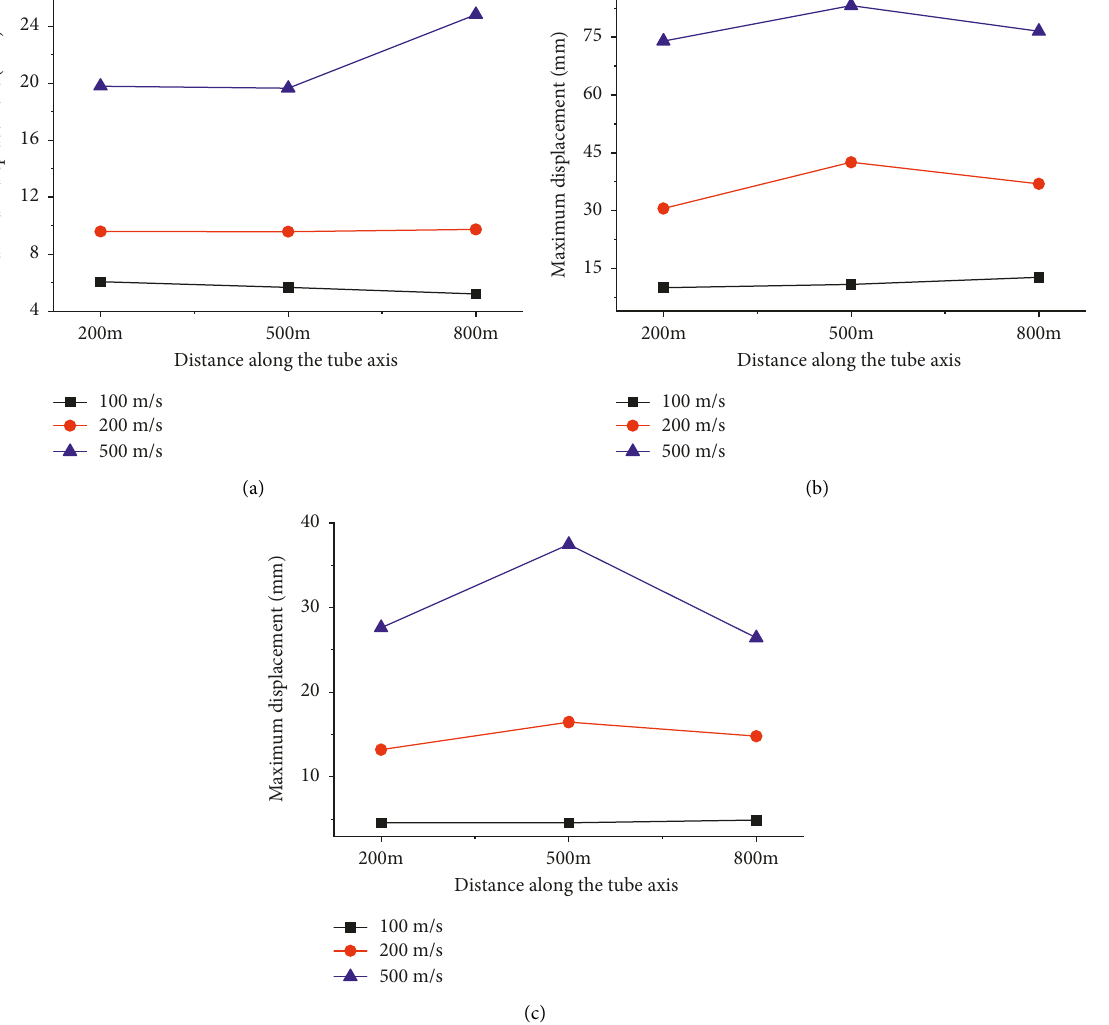
Figure 9: Maximum value of transverse vibration displacement of the pipeline under different wave velocities. (a) Normal, (b) vacant, and (c) polymer grouting